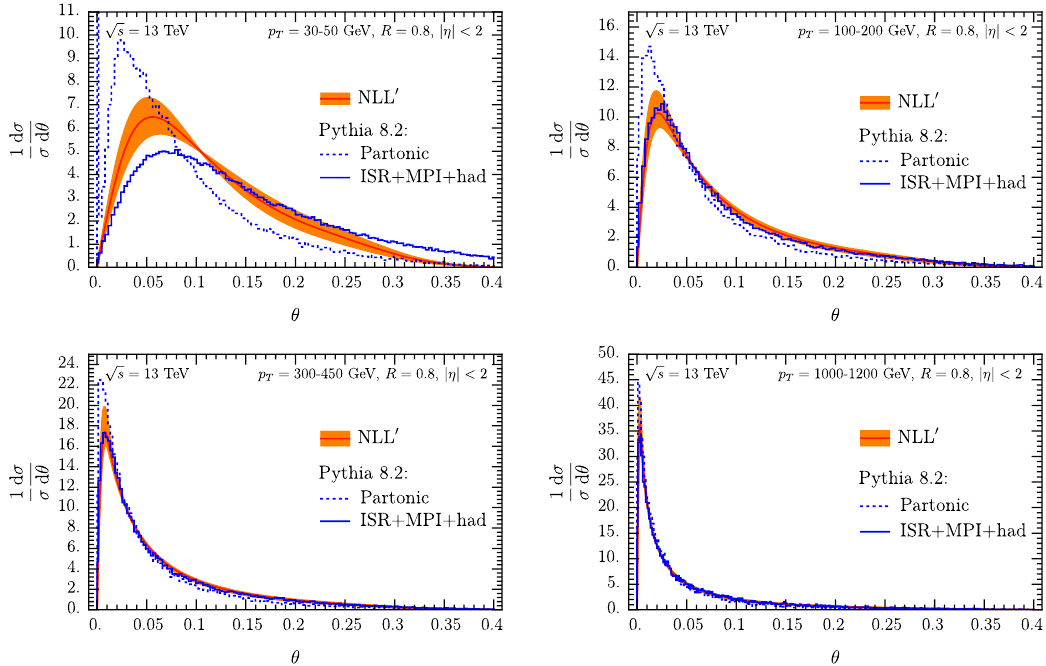
0 (cid:17) < 2. For comparison, we show Pythia 8.2 j j